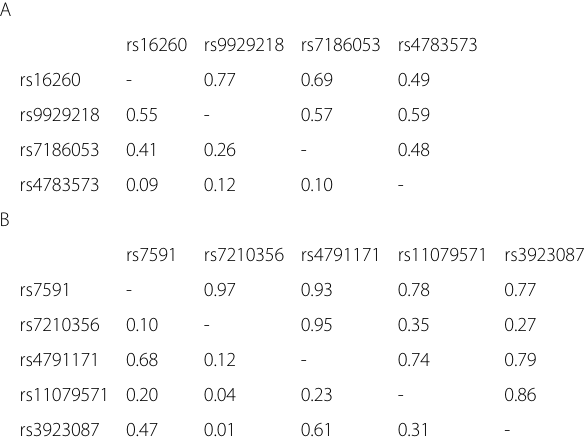
Table 5 Linkage disequilibrium analysis of the CDH1 (A) and AXIN2 (B) SNP. D ’ coefficient is above the diagonal and r ’ is below